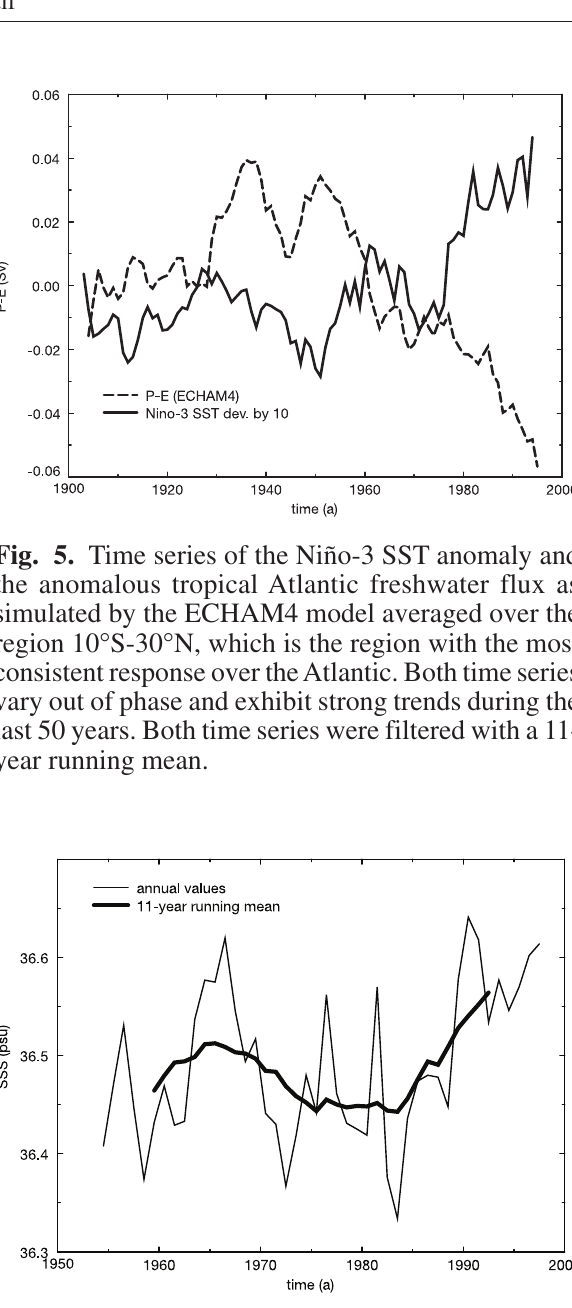
Fig. 6. Time series of the salinity observed at Bermuda (33 ° N, 65 ° W). Please note the strong increase of the salinity during the most recent